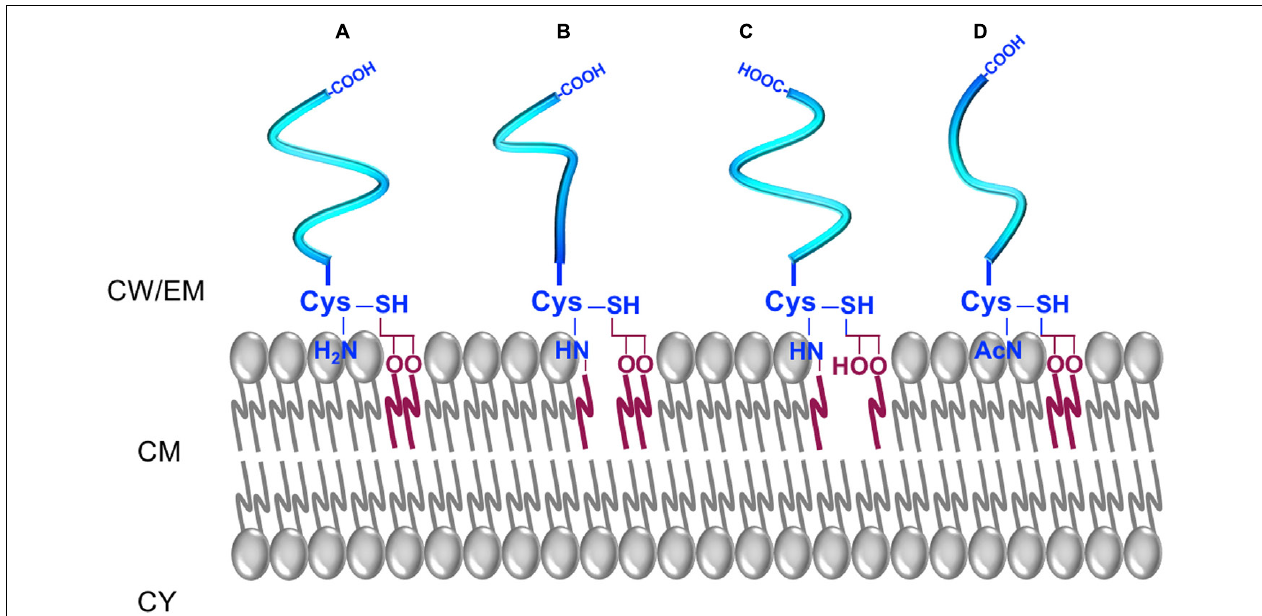
FIGURE 5 | The different forms of lipoproteins in parietal monoderm bacteria. (A) A diacyl-lipoprotein contains an N -acyl- S -diacylated cysteine residue. (B) A N -acylated-triacyl-lipoprotein contains an N -acyl- S -triacylated cysteine residue. (C) A lyso-lipoprotein contains an N -acyl- S -monoacyl-glyceryl-cysteine. (D) A N -acetyl-form contains a N -acetyl- S -diacyl-glyceryl-cysteine.